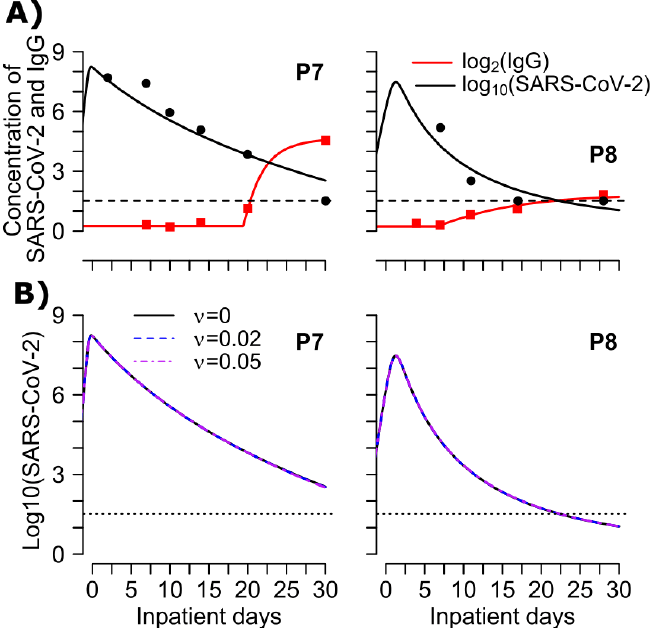
Figure 6. ( A ) Mathematical model fits viral load and antibody levels following SARS-CoV-2 infection. Simulations (lines) to observed SARS-CoV-2 (black markers) and anti-spike IgG (red markers) under the best model (MP-v2 in Table S3). ( B ) Impact of binding effects of spike IgG antibodies on viral dynamics. The solid black line represents the best fits to the observed data (using parameter values in Table S5 estimated under model MP-v2 in Table S3), the dashed blue line representing the case when we assume weak binding effects ( 𝜈 = 0.02 ), and the dashed-dotted purple line represents an enhanced strong binding efficacy of IgG antibodies ( 𝜈 = 0.05 ). The lines all notably overlap.